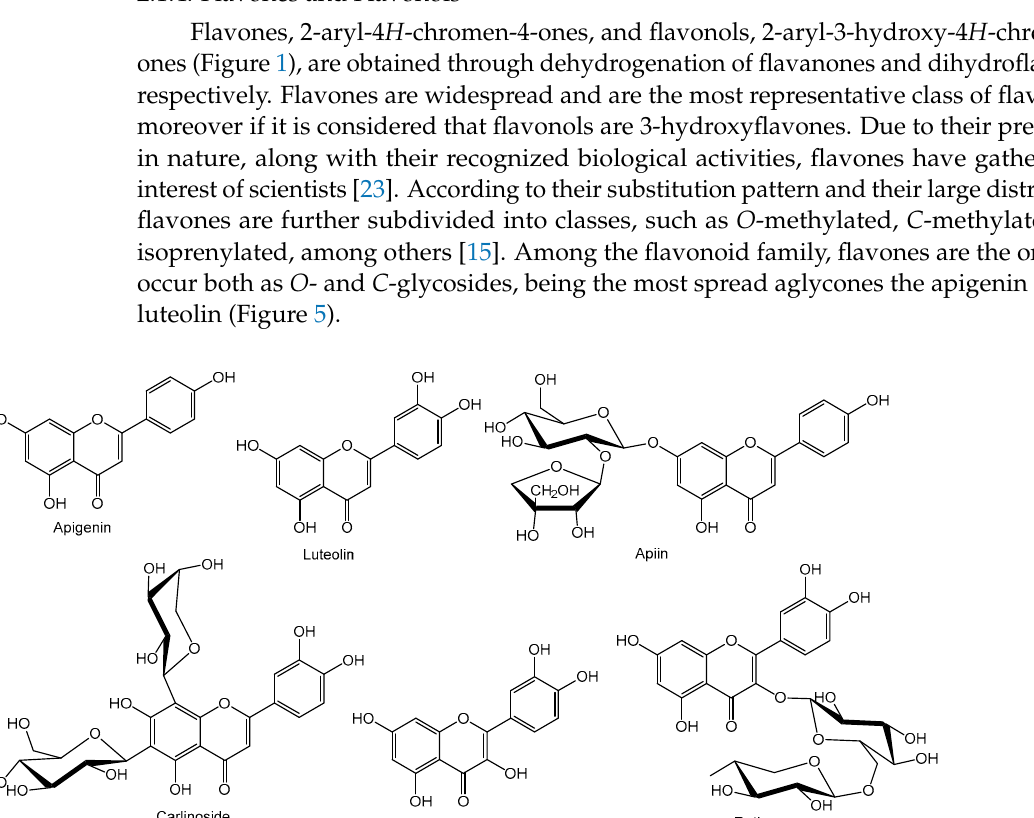
Figure 4. Examples of representative isoflavones.